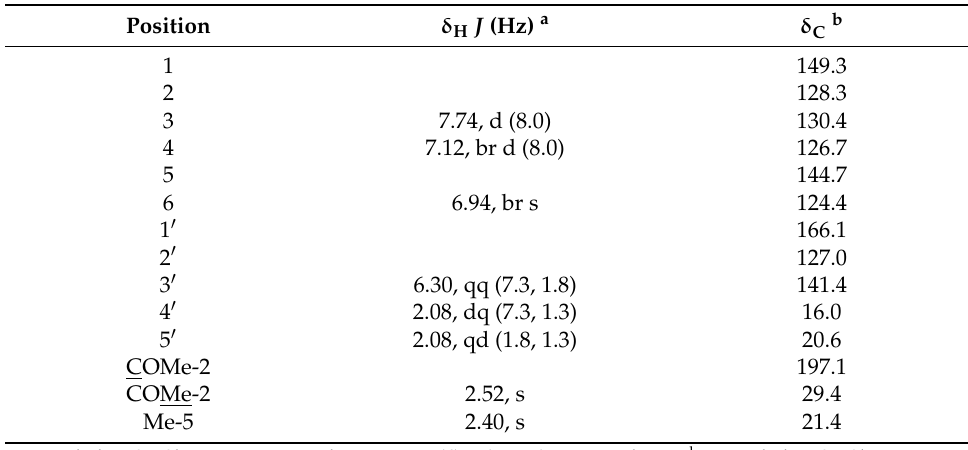
Table 3. 1 H and 13 C NMR data of 4 .